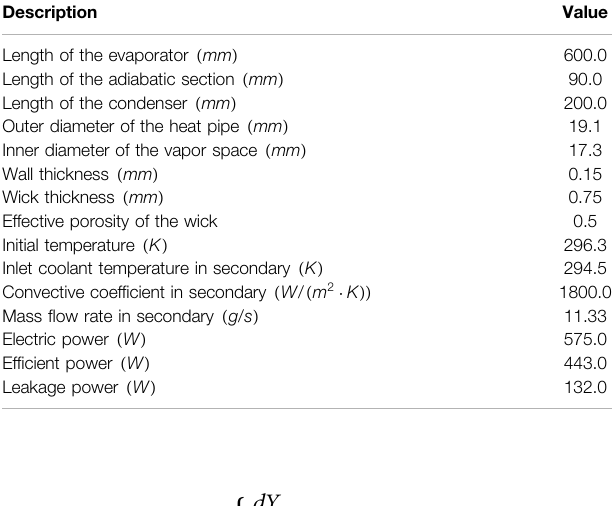
TABLE 1 | Basic description of a copper-water heat pipe (Huang et al., 1993).